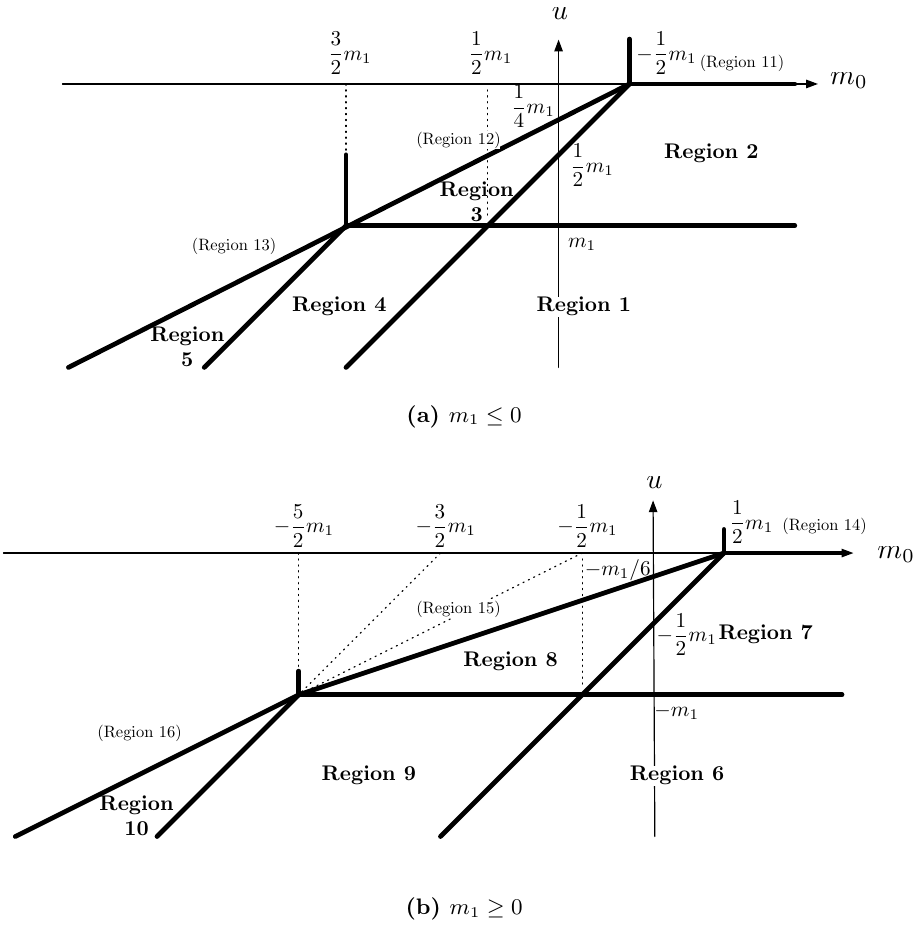
Figure 11. The phase diagram for the E 2 theory with a (cid:12)xed m 1